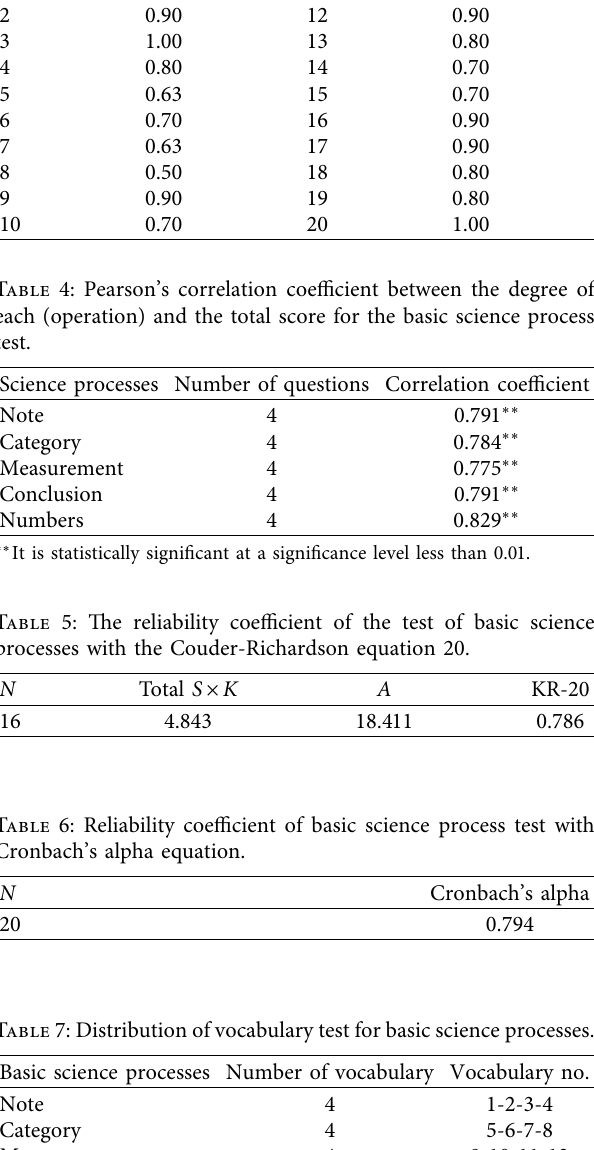
Table 3: Discrimination coefficient for basic science process test questions. Discrimination coefficient